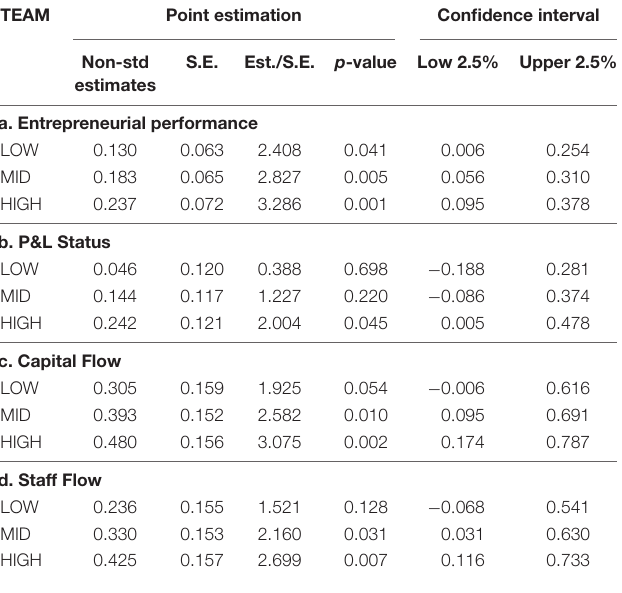
TABLE 5 | Results of simple slope